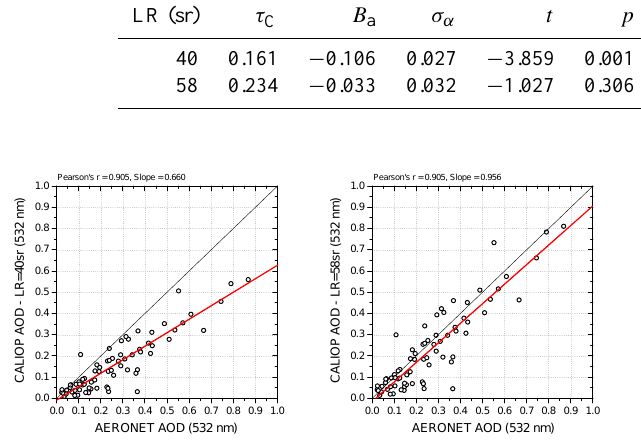
Table 1. Statistical indicators for CALIPSO and AERONET comparisons under different LR assumption for CALIOP (40sr vs. 58sr). Average CALIPSO aerosol optical depth at 532nm ( τ C ) , absolute bias ( B a ) , absolute standard error ( σ a ) , Student’s t test score ( t ), p value ( p ), relative bias, ( B r ) , root-mean-square error (RMSE), correlation coefficient ( R fit ) , slope ( S fit ) and intercept ( I fit ) of the linear fit and number of comparisons ( N ) are shown. Average AERONET aerosol optical depth at 532nm for this dataset is 0.267. LR (sr) τ C